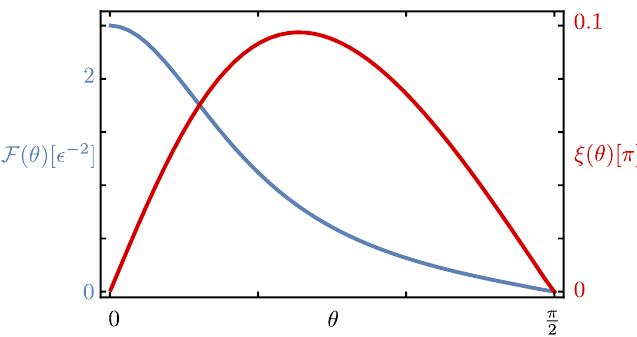
Figure 5: Functions F ( R , θ ) (in blue) and ξ ( R , θ ) (in red) for R = ε